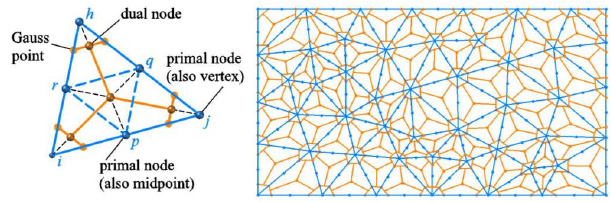
Figure 40: Construction of the dual polygons (a), and primal ( blue thin line) and dual ( orange thick line) mesh for a plane domain (b).